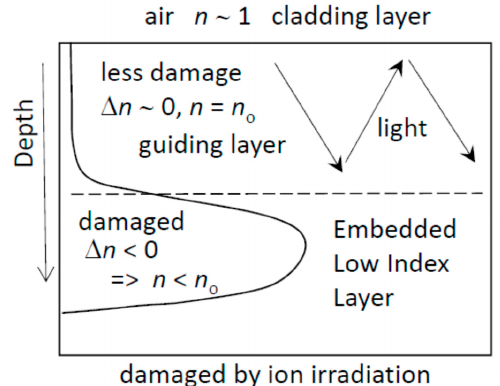
Figure 2. Schematically depicted depth profiles of damage induced by a few MeV light ions. The refractive index is reduced around the depth of the Bragg peak due to strong damage, while the index in shallower region seldom changes. Consequently, a slab-type waveguide is formed only by the irradiation of a few MeV light ions.